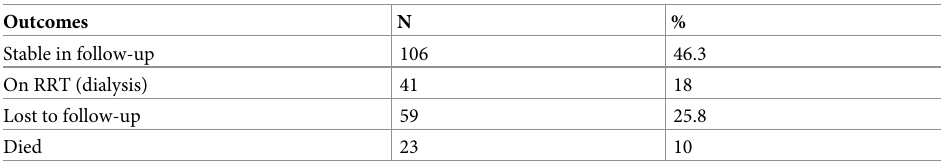
Table 3. Outcome at final follow-up among children who presented with CKD. Outcomes